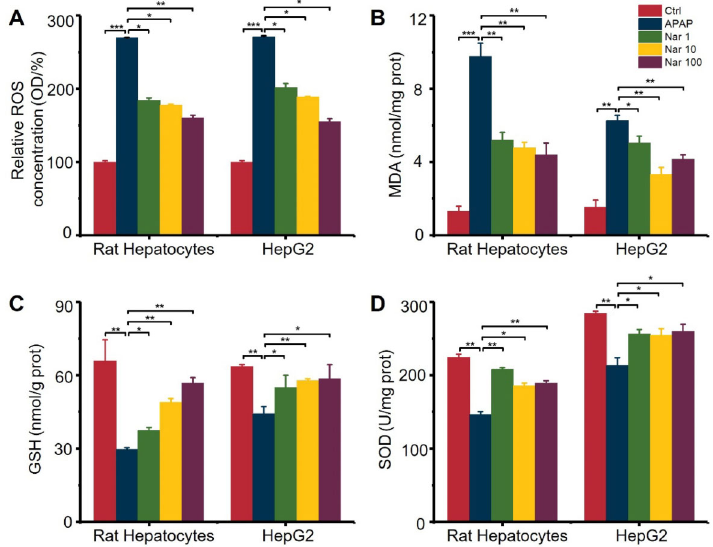
Figure 2. Effect of naringin (Nar) on oxidative stress induced by acetaminophen (APAP) in primary rat hepatocytes and HepG2 cells. The concentration of ( A ) reactive oxygen species (ROS), ( B ) malondialdehyde (MDA), ( C ) glutathione (GSH), and ( D ) superoxide dismutase (SOD) were detected by ELISA. Data are reported as means ± SD (n=3). *P o 0.05, **P o 0.01, and ***P o 0.001 (ANOVA).